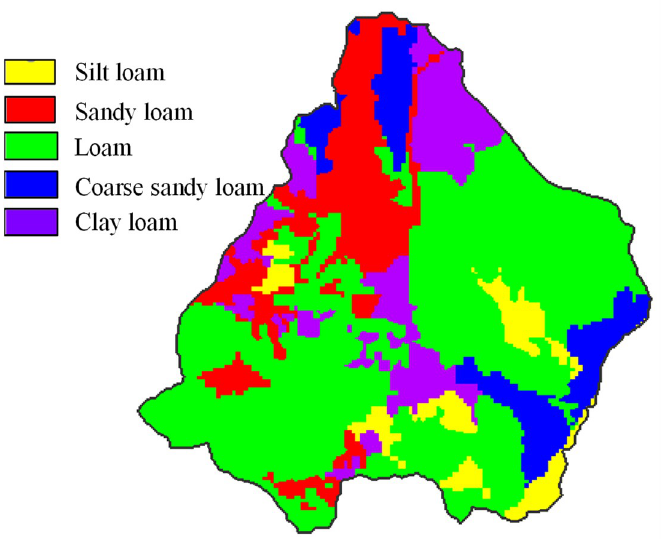
Figure 2. Soil texture classification in the Reynolds Creek Experimental Watershed study catchment.